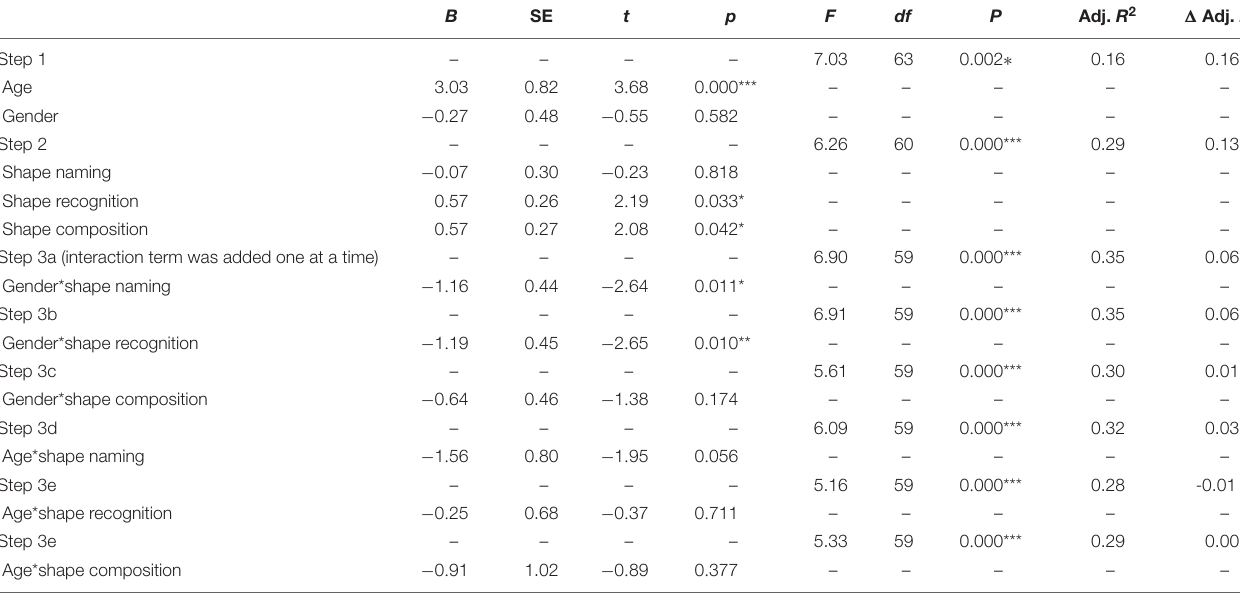
TABLE 3 | Hierarchical linear regression predicting block building ability ( N =